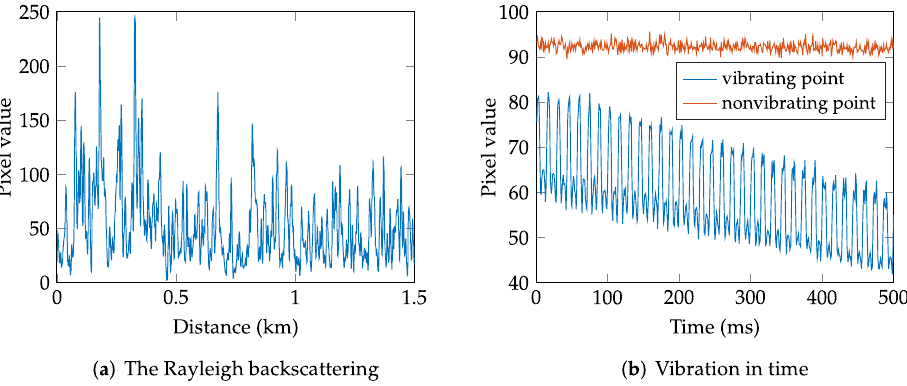
Figure 1. ( a ) One Rayleigh scattering response from the fiber; ( b ) time measurement showing idle state (red) and vibration